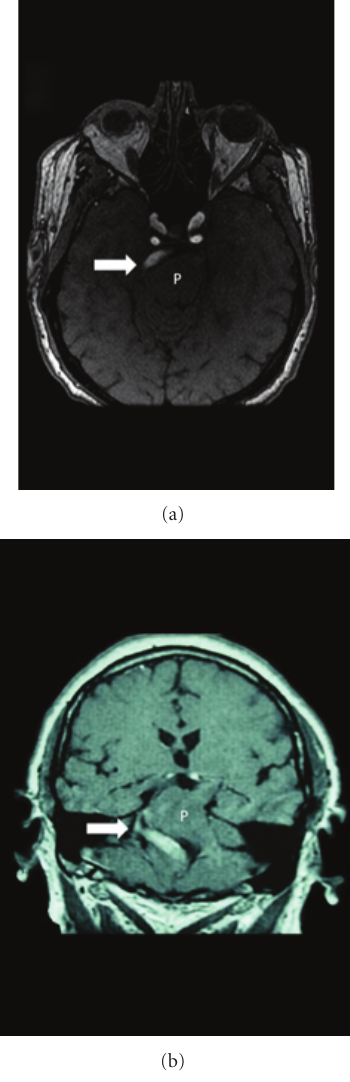
Figure 2: (a) (Axial) and (b) (coronal) magnetic resonance angio- gram image shows enlarged and tortuous basilar artery. The basilar artery is moved more than 10 mm to the right